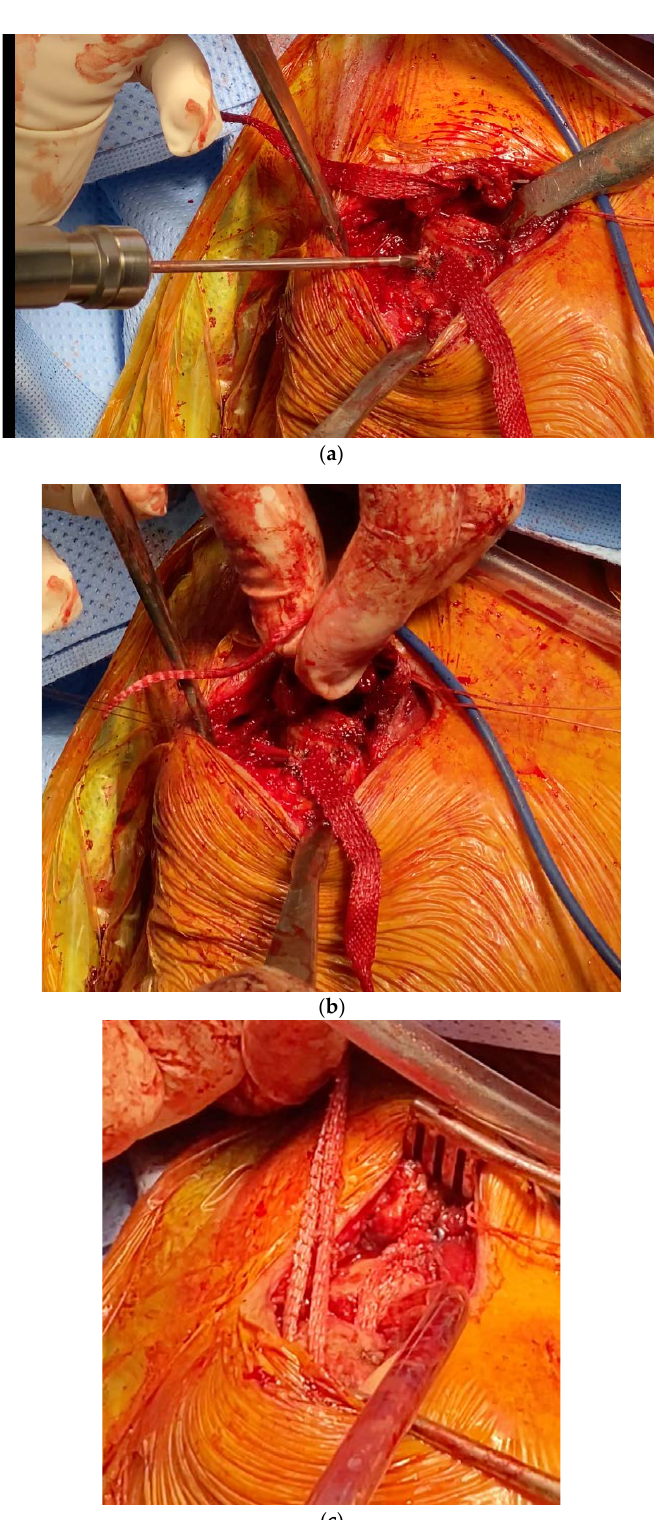
Figure 3. The modification of technique, with final phases. ( a ) a guidewire is drilled twice, perpendicularly, through the acromial process, ( b ) the CC-Hook is used to pass the limbs of the Tube-Tape through the two bone tunnels, running from the inferior to the superior surface of acromion, ( c ) final construction.